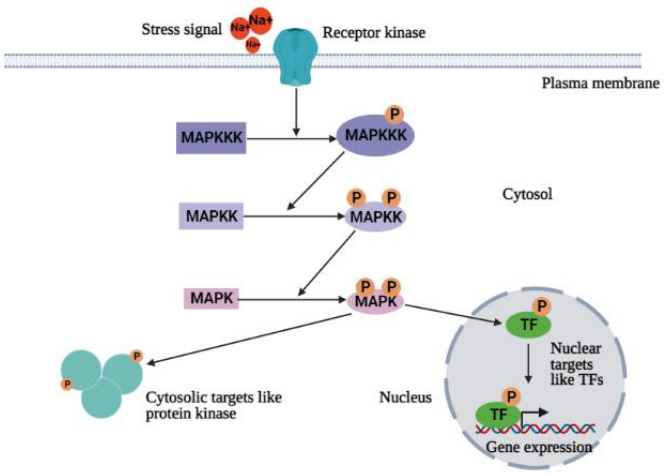
Figure 5. The mode of the MAPK cascade. Additional details are in the text.